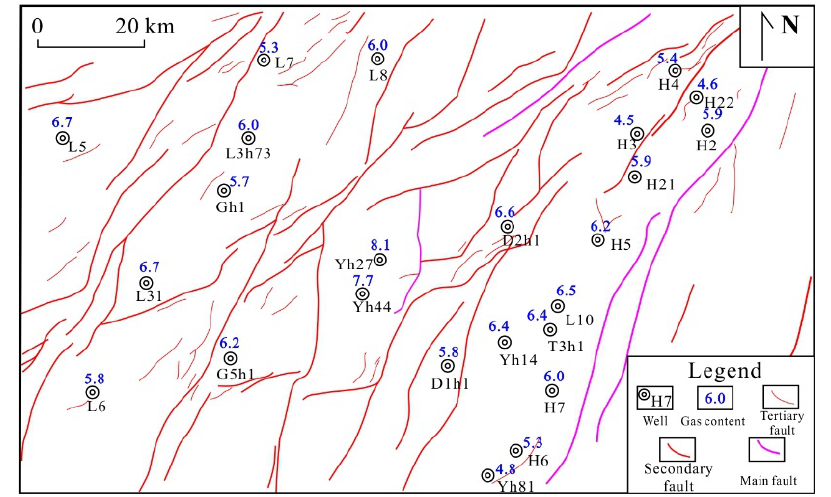
Figure 7. Fault development characteristics of the Longmaxi Formation in the study